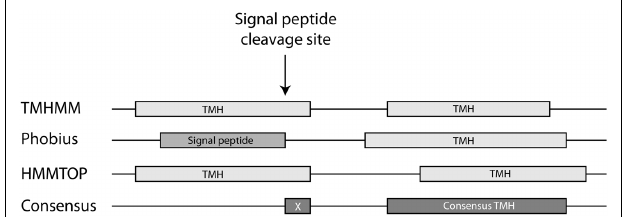
FIGURE 3 |Threshold determination for the assignment of subcellular localizations to whole clusters. (A) For Gram-negative bacteria; (B) for Archaea. In both cases, the number of clusters annotated as “uncertain” (i.e., with no SCL prediction above the